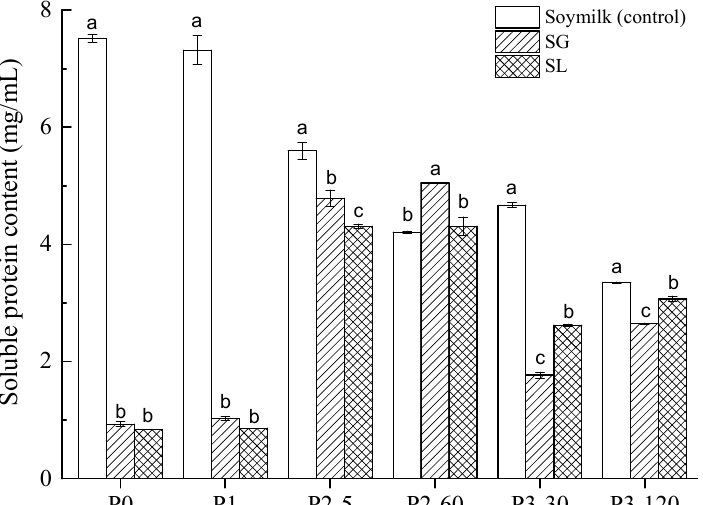
Figure 1. Soluble protein content (mg/mL) of soymilk (control), soymilk gel produced by GDL (SG), and soymilk gel induced by LAB (SL) samples at various digestion stages. Within the same digestion phase, different lowercase letters indicate significant differences ( p < 0.05). P0 represents the sample before in vitro GIS digestion; P1 represents the sample after buccal digestion; P2-5 and P2-60 indicate samples collected at 5 min and 60 min of gastric digestion, respectively; and P3-30 and P3-120 indicate samples collected at 30 min and 120 min of intestinal digestion, respectively.